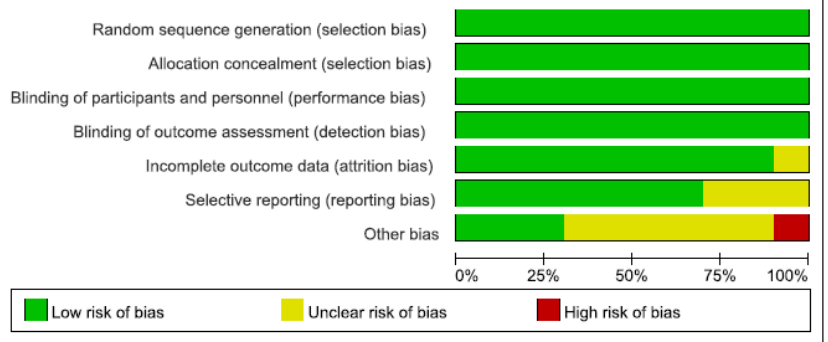
Table 1. Characteristics of studies included in the meta-analysis.